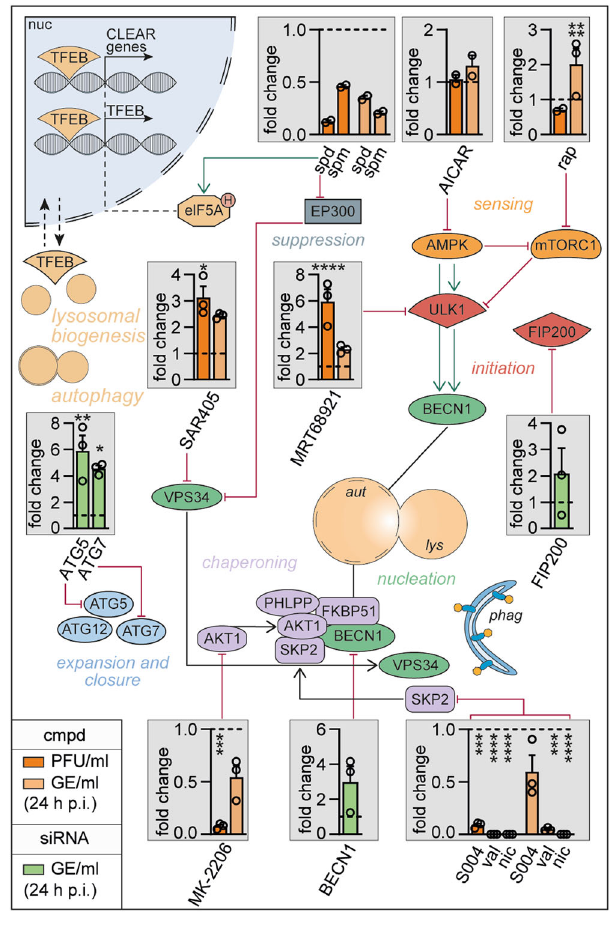
(Supplementary Fig. 10; Supplementary Table 9). Virus growth was monitored by plaque assays to quantify the infectious par- ticles and real-time RT-PCR to detect genome equivalents per ml (GE/ml) in cell culture supernatants 24 and 48 h p.i. (Supple- mentary Fig. 11a). For key autophagy proteins, siRNA-based knockdown experiments were additionally performed (Fig. 4, green columns, Supplementary Fig. 11b). The effects of all sub- stances were monitored during the exponential growth phase of the virus at 24 h p.i. to circumvent interfering effects like cyto- pathogenicity and apoptosis (Fig. 4).